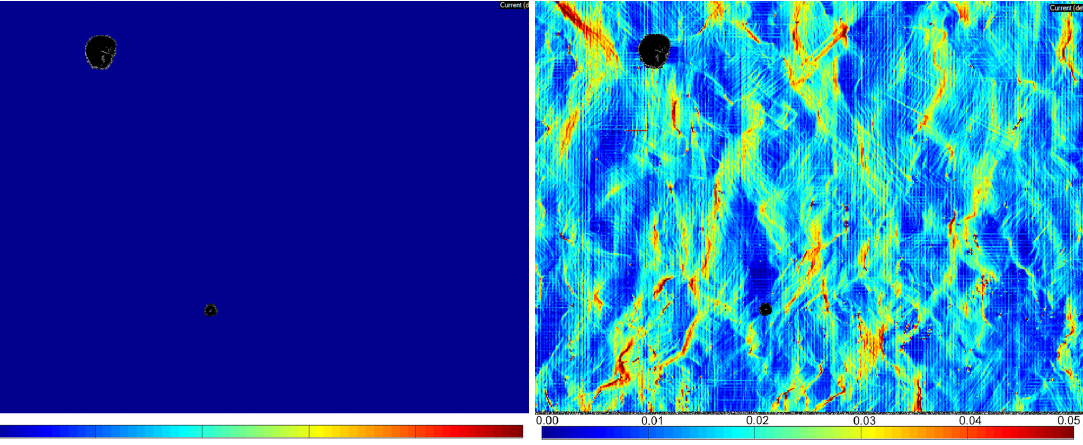
Figure 11. Stitched BSE images at different displacements in the notched specimen. ( a – d ) The micrographs relate to the force–displacement curve in Figure 6. In all frames, the pulling direction in the in situ SEM tensile test is from right to left. Each frame has the same dimensions, 119 µm × 90 µm.